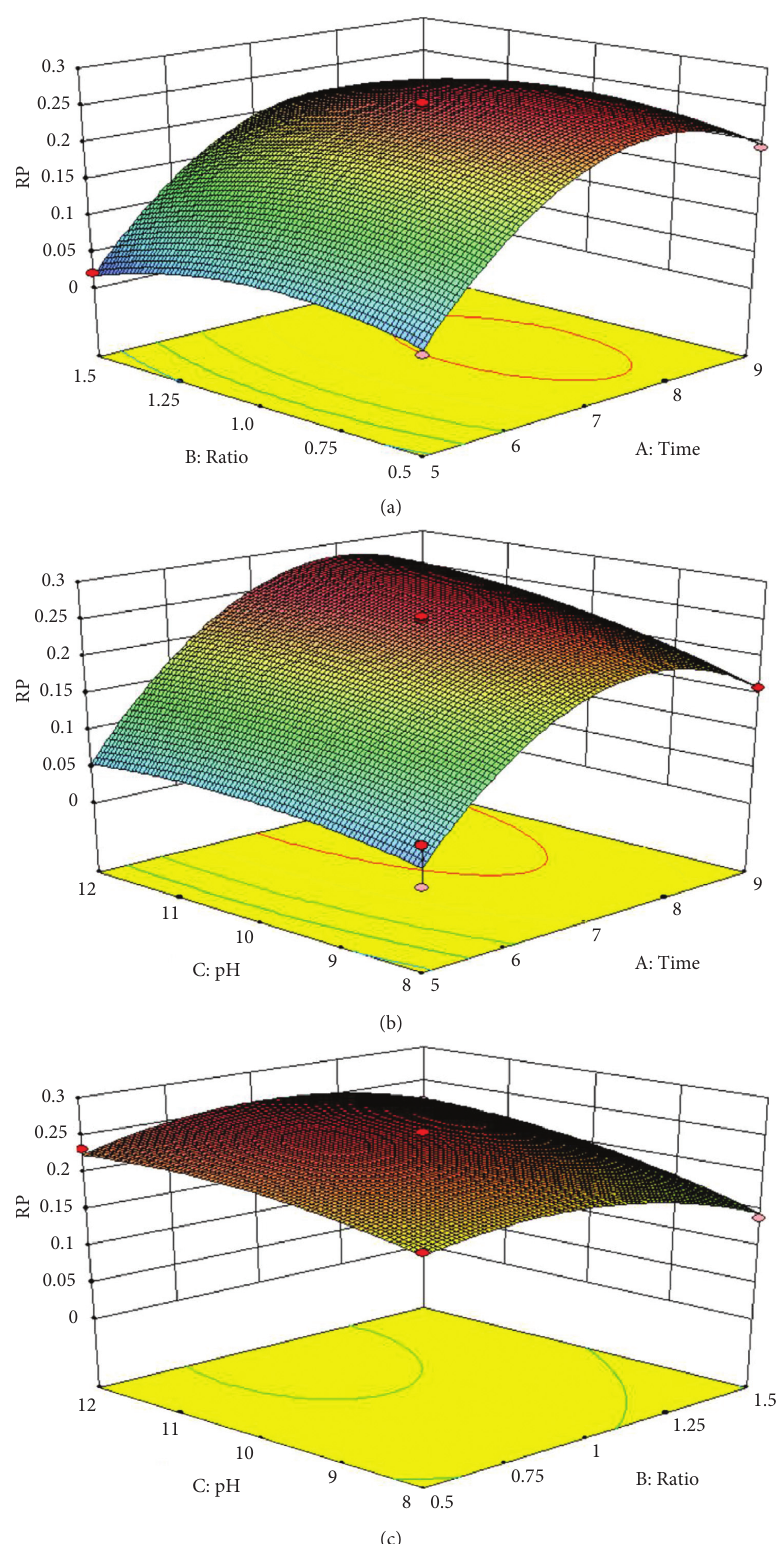
Figure 2: Three-dimensional figures of interactive effects of heating time (time), volume ratio of propylene glycol to ddH (pH) on reducing power (RP) of an L-arabinose/glycine Maillard reaction